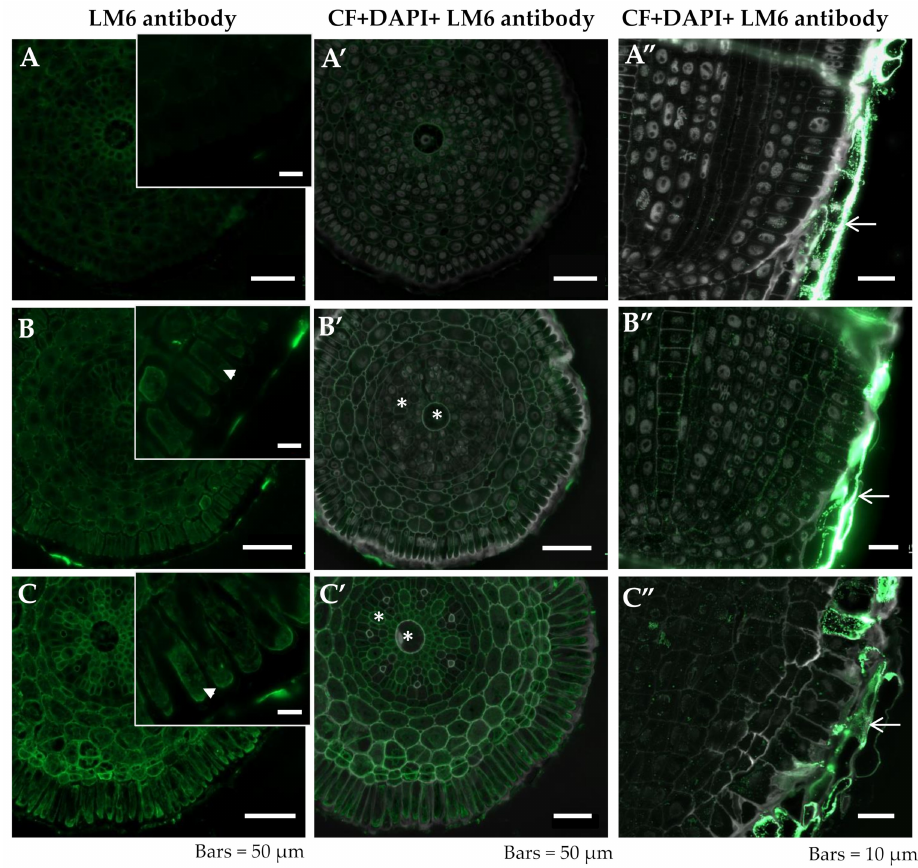
Figure 3. Distribution of LM6 epitope in cross sections in di ff erentiated zone ( A , A’ – C , C’ ) and longitudinal sections in meristematic zone ( A” – C” ) of root tissues of barley cv. Sebastian. ( A – A” )—control pH 6; ( B – B” )—control pH 4; ( C – C” )—30 µ M AlCl 3 . ( A – C )